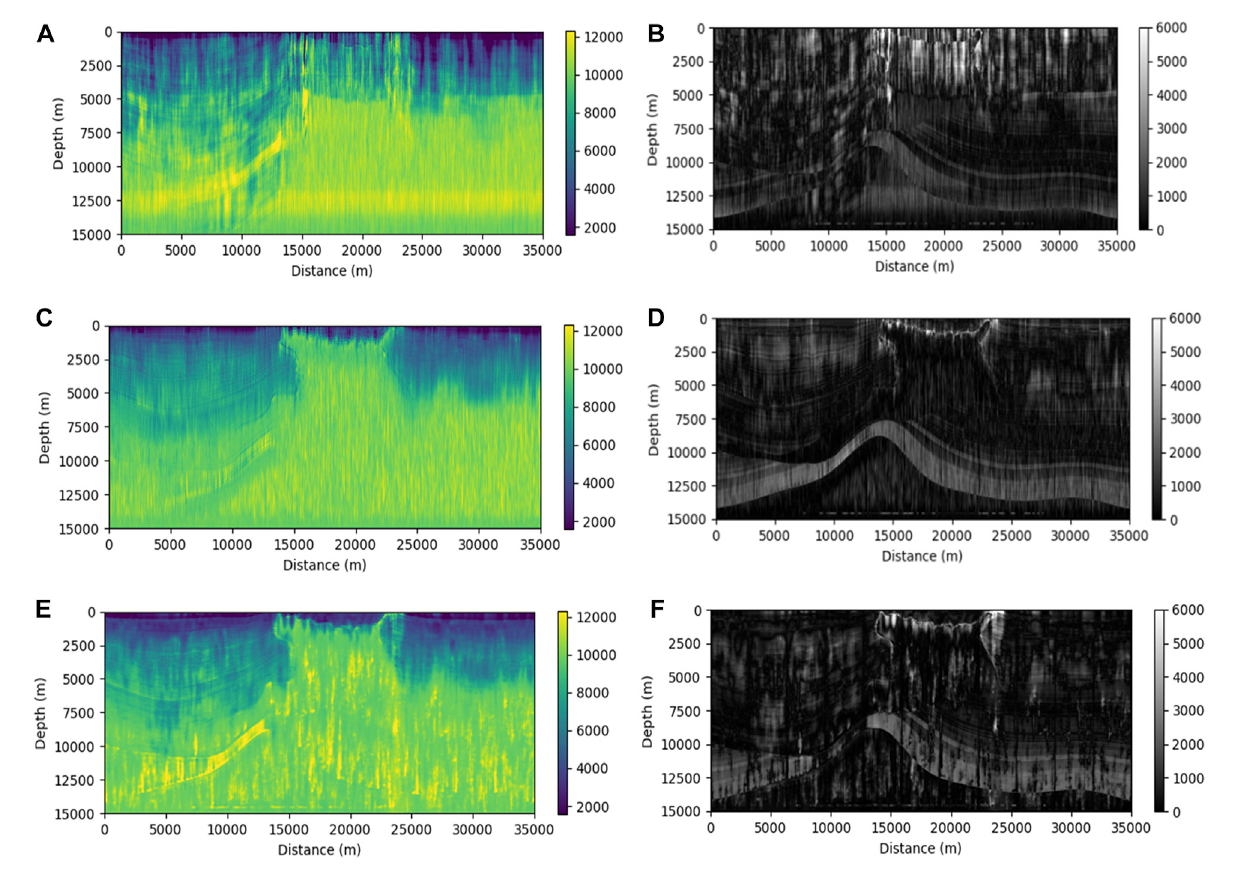
FIGURE 10 Acousticimpedanceinversion pro fi lesandresidualpro fi lesontheSEAMmodel. (A) Inversion resultofCNNmethodanditsresidual (B) . (C) Inversion result of U-Net method and its residual (D) . (E) Inversion result of the method in this paper and its residual (F)